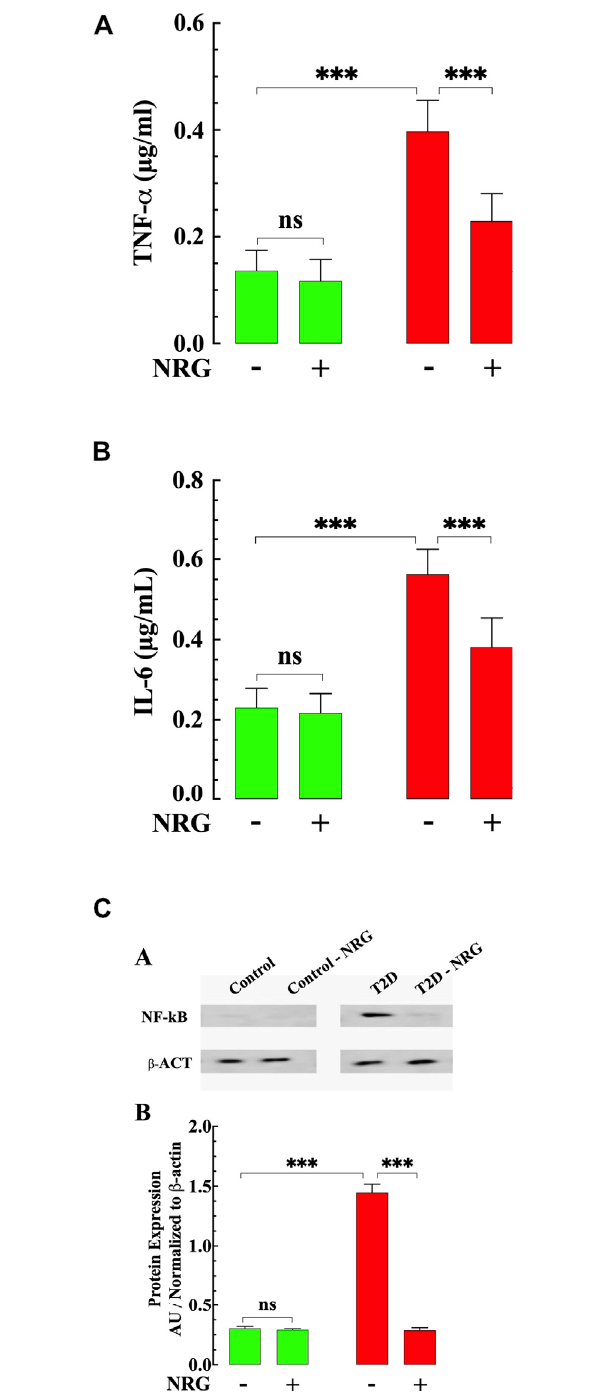
FIGURE 4 | tissues ( p < 0.001). Naringin signi fi cantly lowered tissue IL-6 in T2D ventricular cells ( p < 0.001 compared to untreated ventricular cells). No effect on basal IL-6 levels was observed in control naringin-treated ventricular tissue compared to untreated control ( p (cid:1) 0.30). (C) Top: representative Western blotting analysis of NF-kB in myocardium from naringin-treated and untreated-control and T2D mice. Bottom : Densitometric analysis of Western blot experiments. Expression of p65- NF-kB was signi fi cantly upregulated in T2D myocardium tissue compared to control tissue ( p < 0.001). Naringin FIGURE 4 | Effects of naringin on TNF- α , IL-6, and NF-kB in T2D treatment normalized the expression p65- NF-kB in T2D cardiac tissue ( p < ventricular tissues. (A) T2D ventricular tissue had a signi fi cantly TNF- α higher 0.001) with no effect on control ( p (cid:1) 0.97). Data were normalized to concentration than control ventricular cell ( p < 0.001). Naringin treatment housekeeping protein ß-actin and expressed. TNF- α and IL-6 measurements signi fi cantly reduced TNF- α levels in T2D tissues compared to untreated were obtained from n mice (cid:1) 5 mice/group, n determinations (cid:1) 10/group. Western T2D ( p < 0.001). Naringin treatment did not affect TNF-a levels in control blot experiments were carried out in n mice (cid:1) 3 mice/group, n WB (cid:1) 4/group. ventriculartissue( p (cid:1) 0.98comparedtountreatedcontrol). (B) VentricularIL-6 Values are expressed as means ± S.D. Statistical analysis was performed as levels were signi fi cantly increased in T2D heart tissues than untreated control described before, ns p > 0.05, *** p < ( Continued )